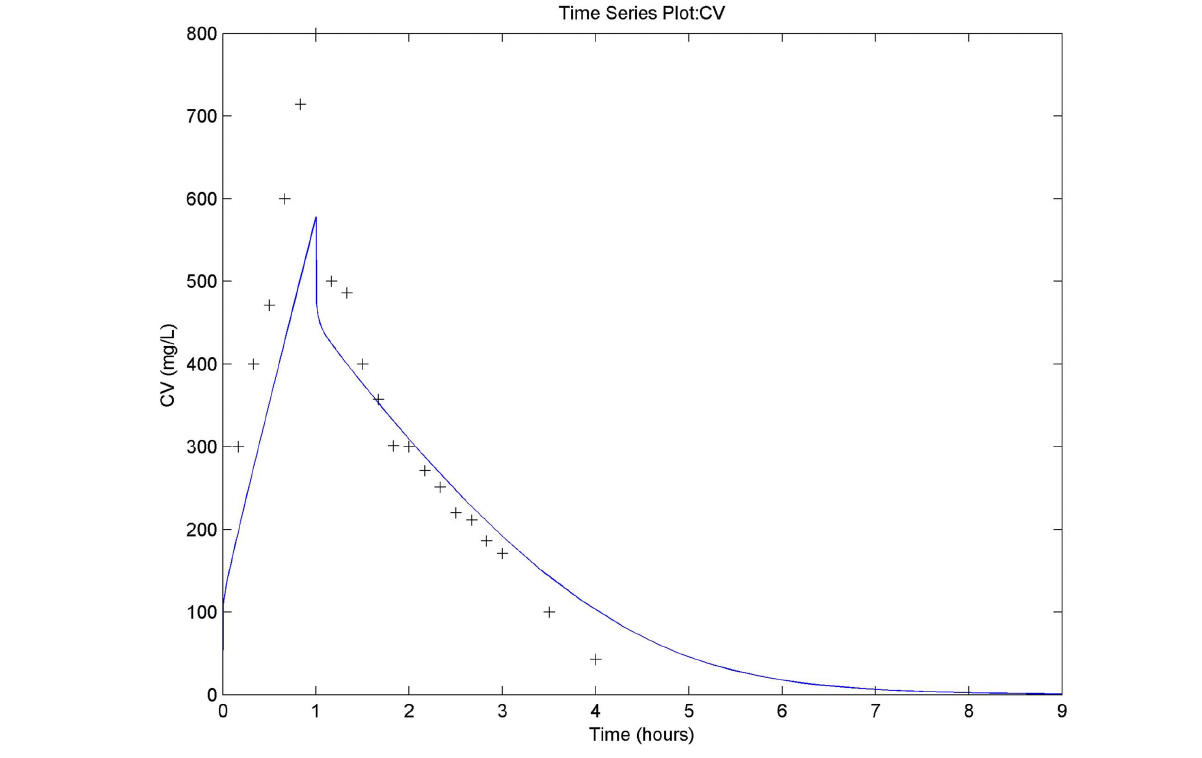
FIGURE 15 | Reproduction of Figure 5 from Loizou and Spendiff (2004). Simulated (line) versus measured (symbols) blood ethanol concentrations following intra-venous administration of 0.4gkg − 1 ethanol for 1h. PBPK model exported in MATLAB version